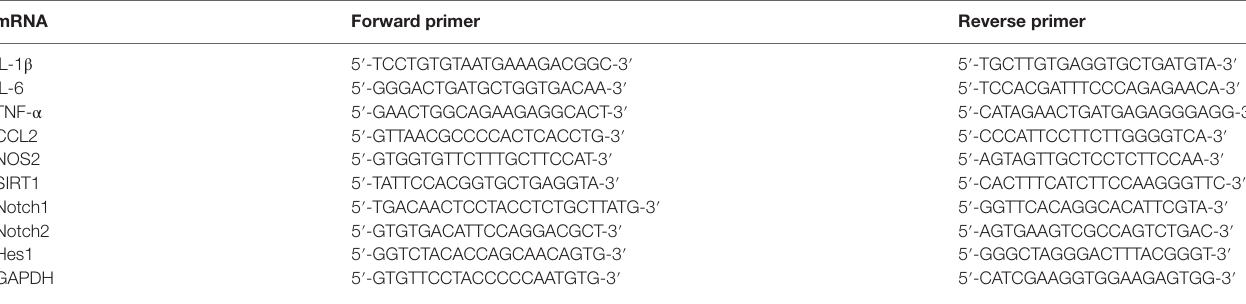
Table 1 | Primer sequences used for real-time-PCR analysis.